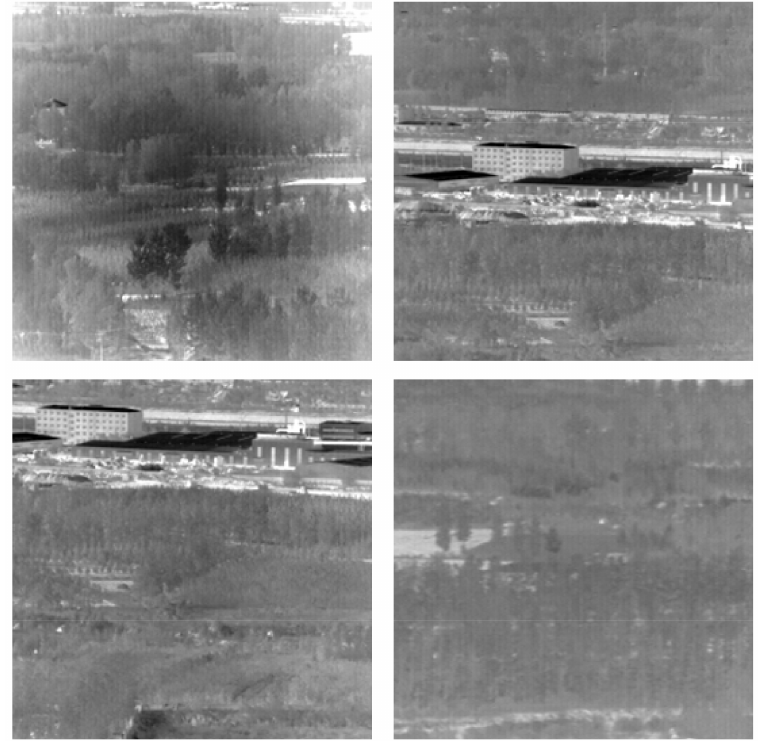
Figure 13. Four kinds of hard